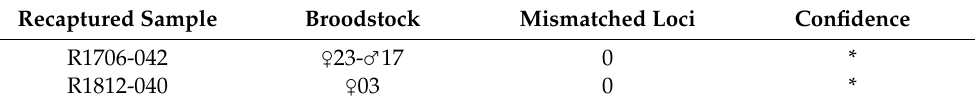
Table 1. Positive result of parentage analysis of recaptured black sea bream samples. Recaptured